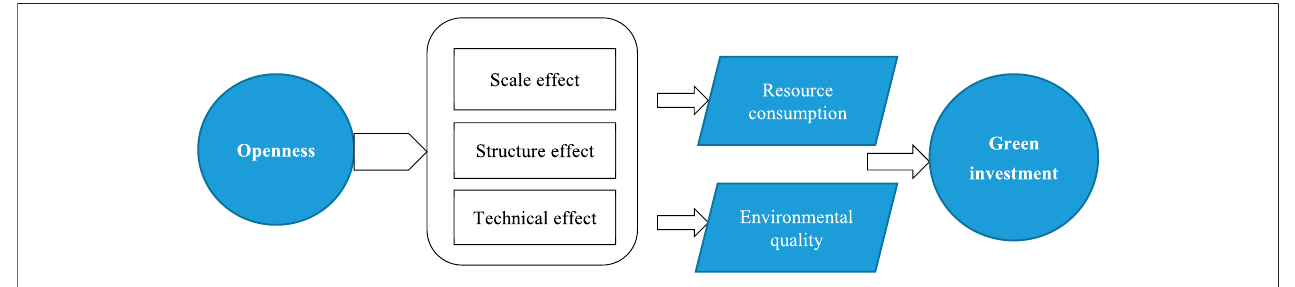
FIGURE 2 | The mechanism of openness on the ef fi ciency of green